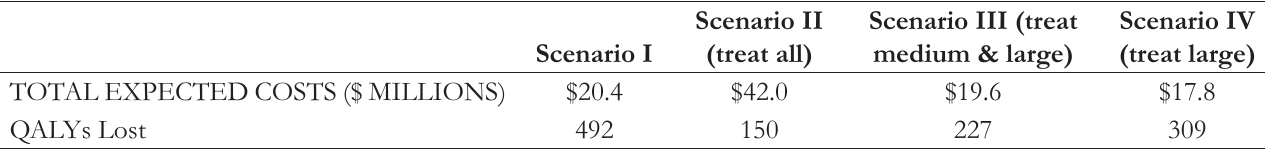
Table 2. Expected Total Costs and QALYs for Each Cohort